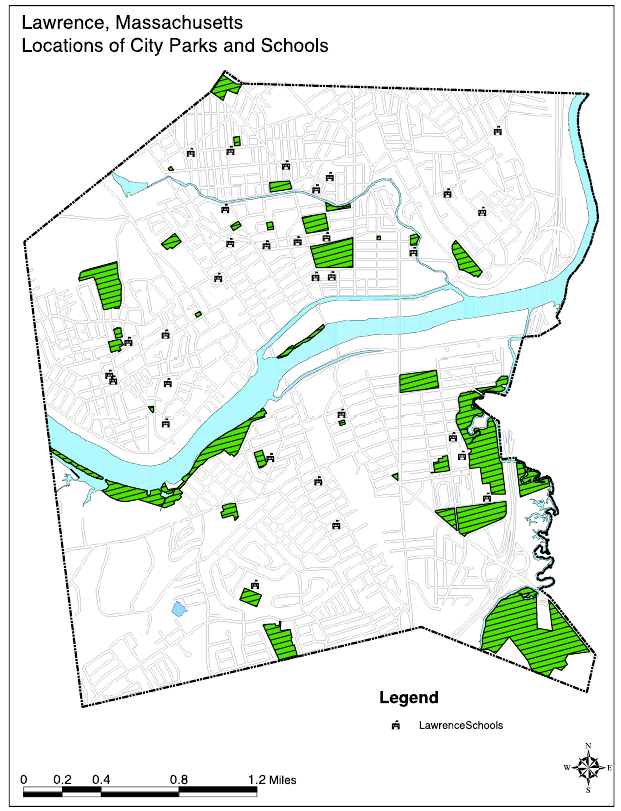
Figure 1. Locations of City Parks and Schools, 2004 [38].